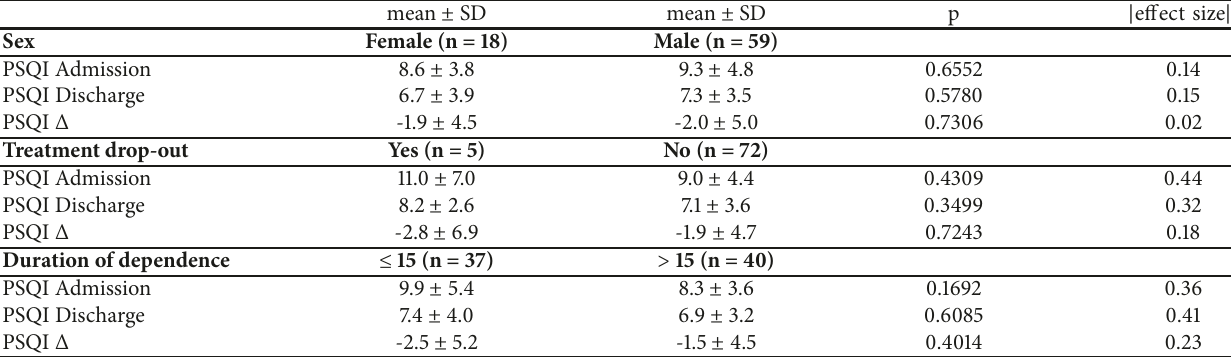
Figure 1: Change of PSQI score during detoxification treatment. Table 1: Univariate statistics of PSQI score at admission and